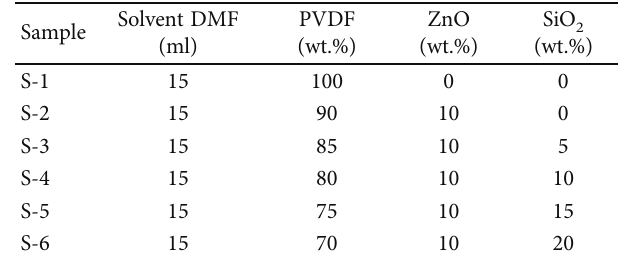
Table 1: Wt.% of precursors used to synthesize PVDF-based NC